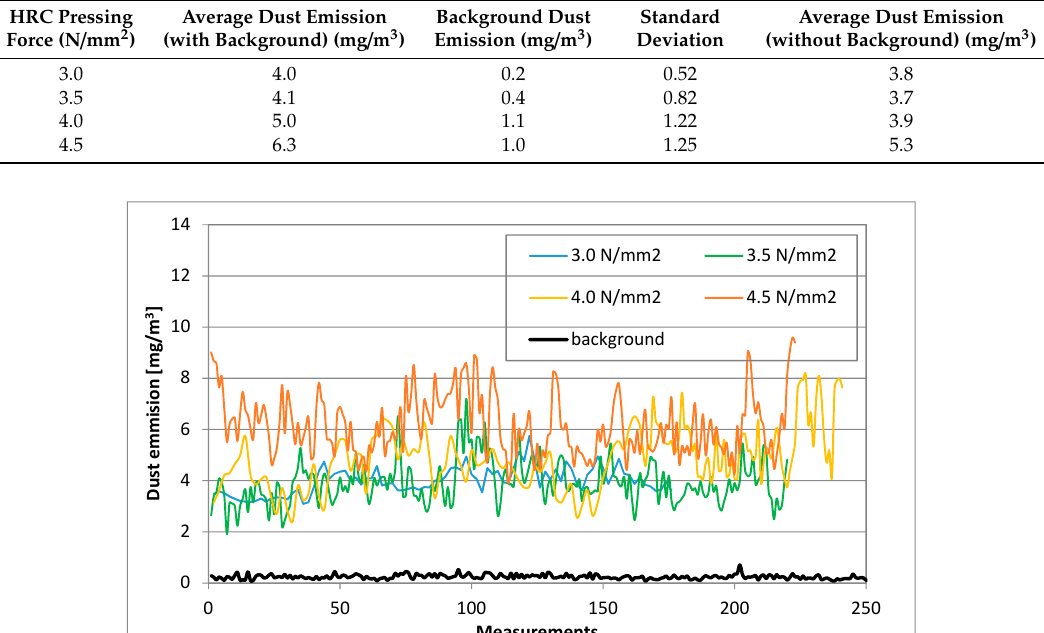
Figure 10. Results of dust emission during HRC device operations at various F sp values.